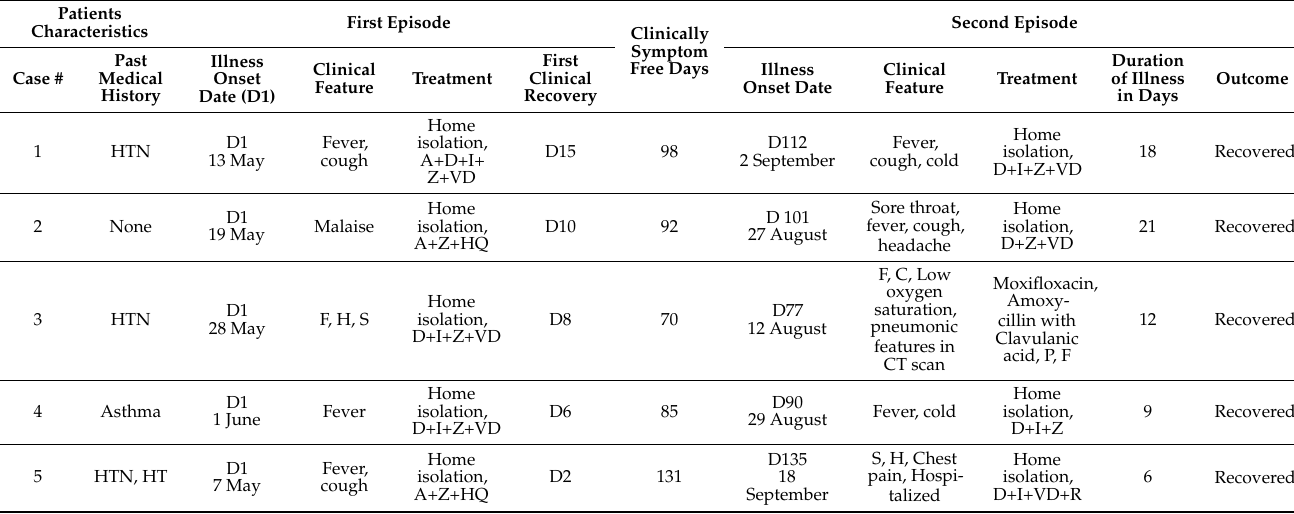
Table 1. Clinical characteristics of the COVID-19 cases for both their first and second episodes of illness. Patients Characteristics